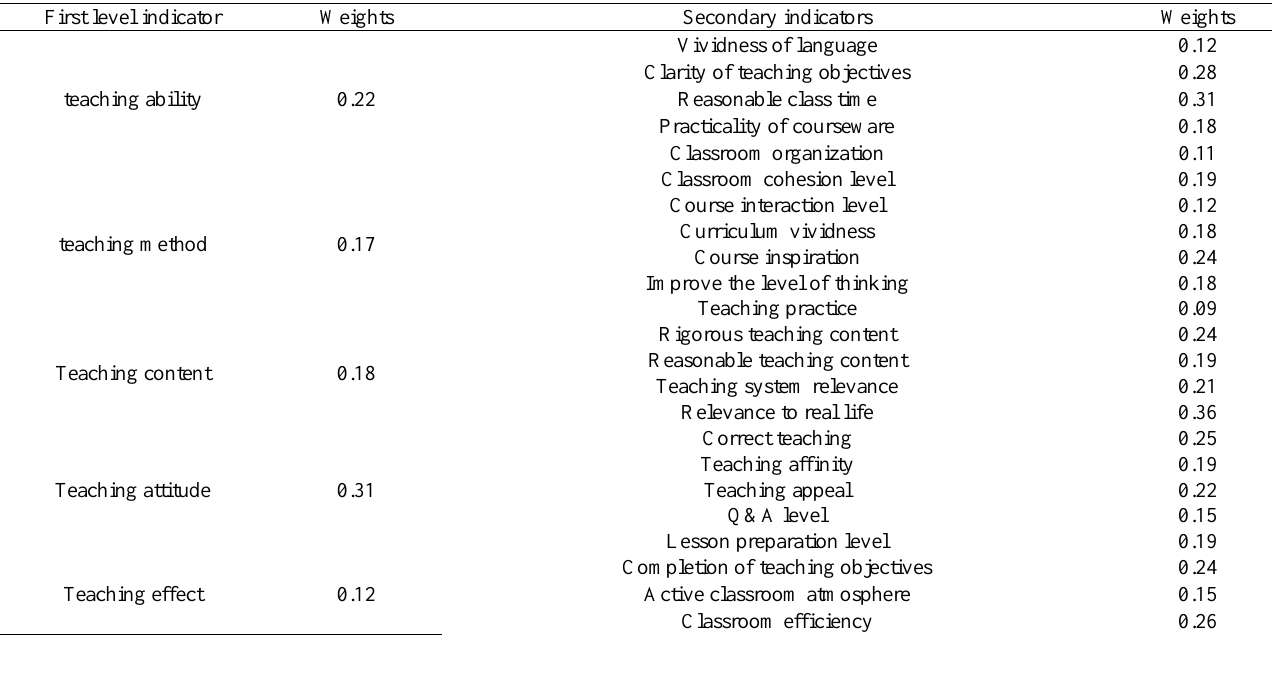
Table 1. Weight calculation results of the evaluation index